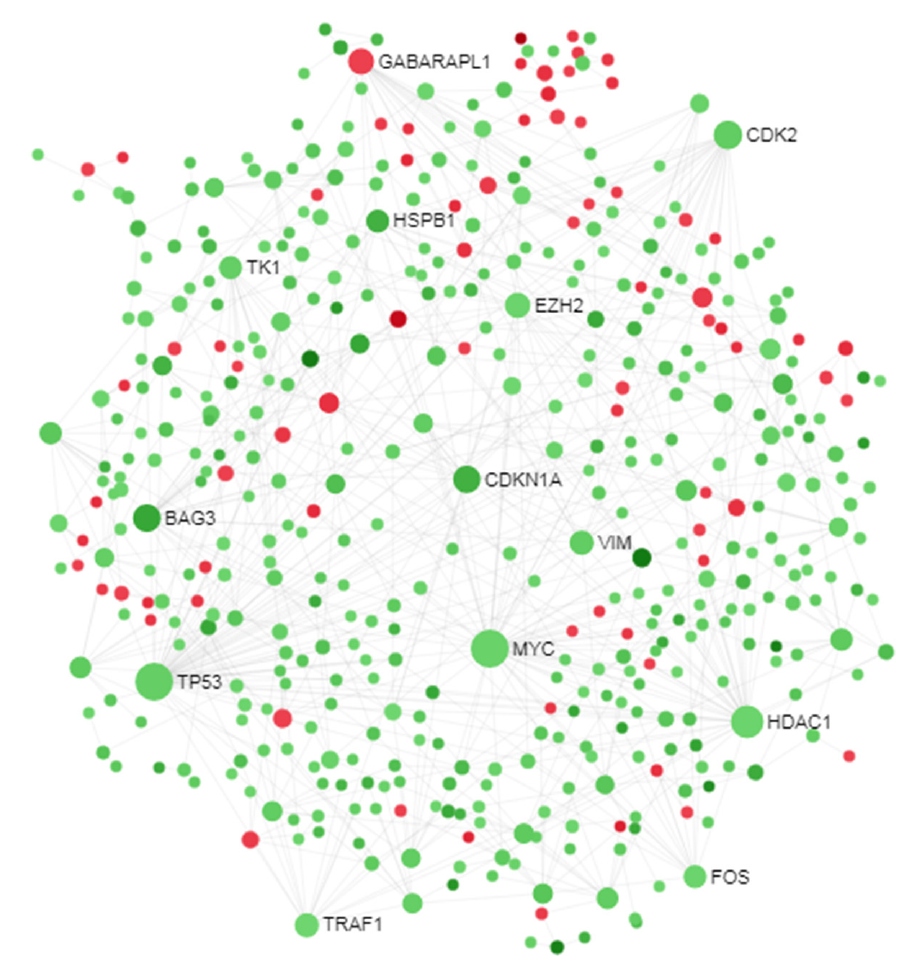
Figure 4. PPI subnetwork analysis of differentially expressed genes (DEGs). Circles represent nodes and grey lines represent interaction partners of the DEGs. The green nodes represent upregulated DEGs, while the red nodes represent downregulated DEGs. Table 3. Hub proteins identified from protein–protein interaction network analysis of corresponding proteins encoded by the di ff erentially expressed genes obtained in the meta-analysis. Gene